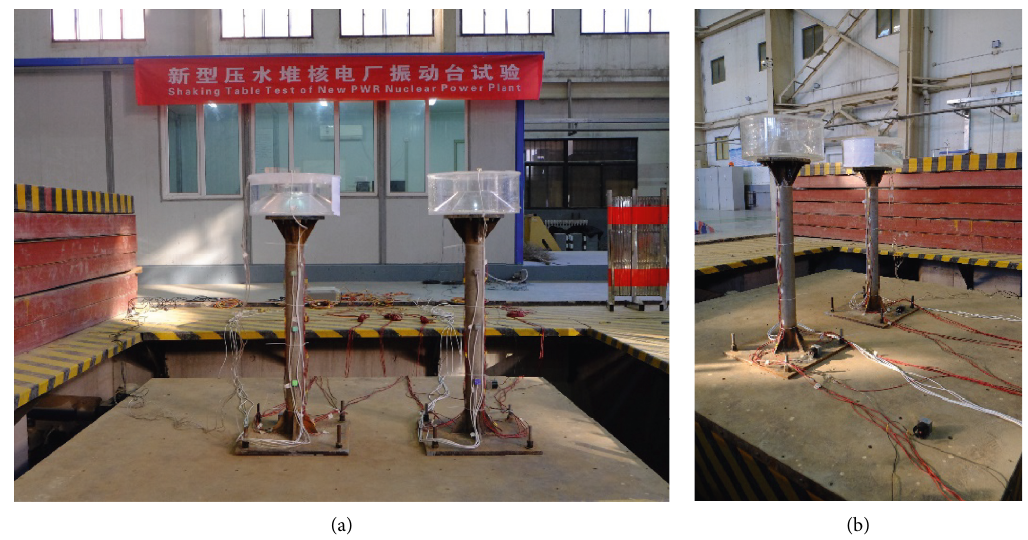
Figure 5: Test system. (a) Front view. (b) Side